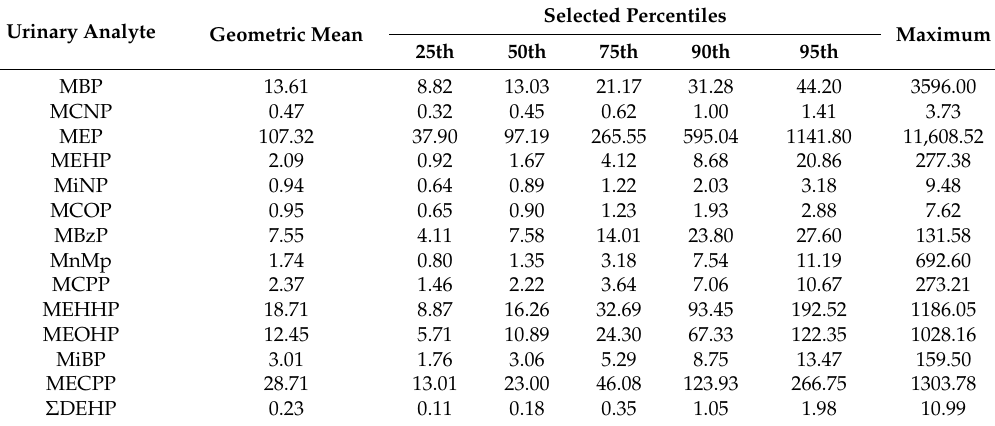
Table 3. Weighted, creatinine-corrected urinary phthalate metabolite concentrations ( µ g/g Creatinine) in males, NHANES